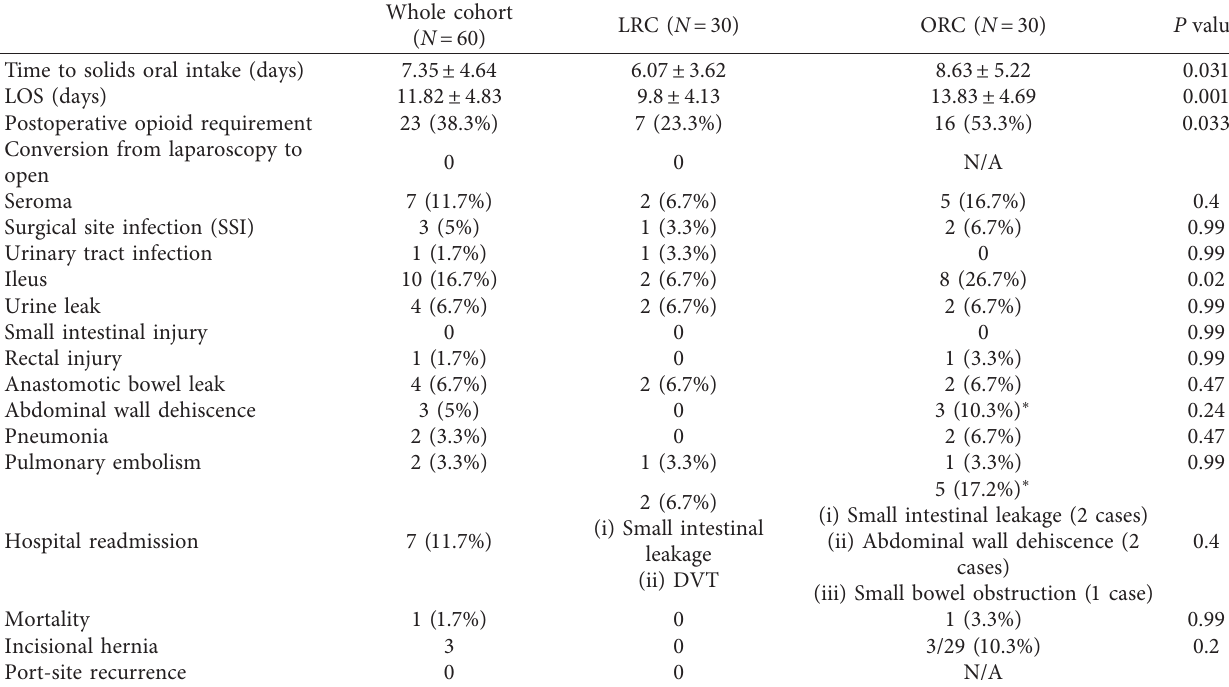
Table 4: Comparison of postoperative outcomes and complications between LRC and ORC